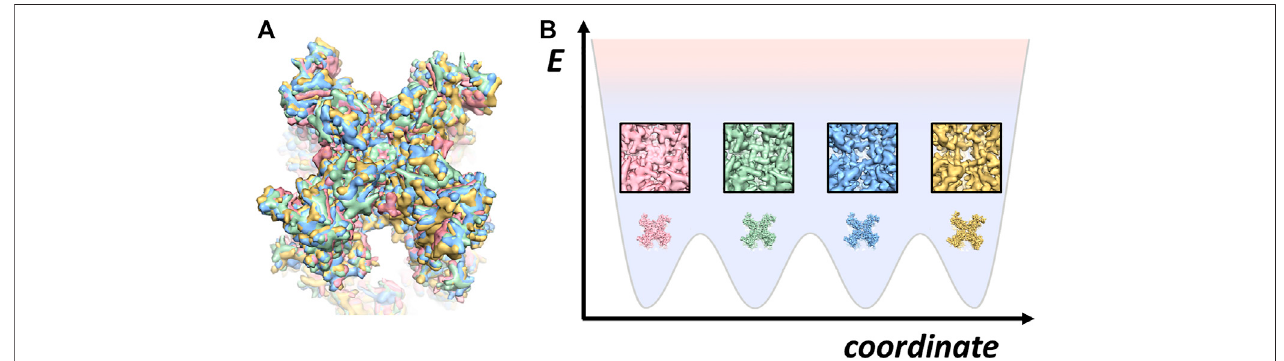
FIGURE1 | Snapshots ofTRPV cryo-EM structures (A) four TRPV structuressuperimposed: apo followed bythree differentconformations bound withDkTx toxin (EMD-23136, PDB: 7L2P; EMD-23143; PDB: 7L2S; EMD-23141; PDB: 7L2T; EMD-23141; PDB: 7L2U) (Zhang et al., 2021). (B) a cartoon of energy landscape for illustrating the four different structures in (A) .